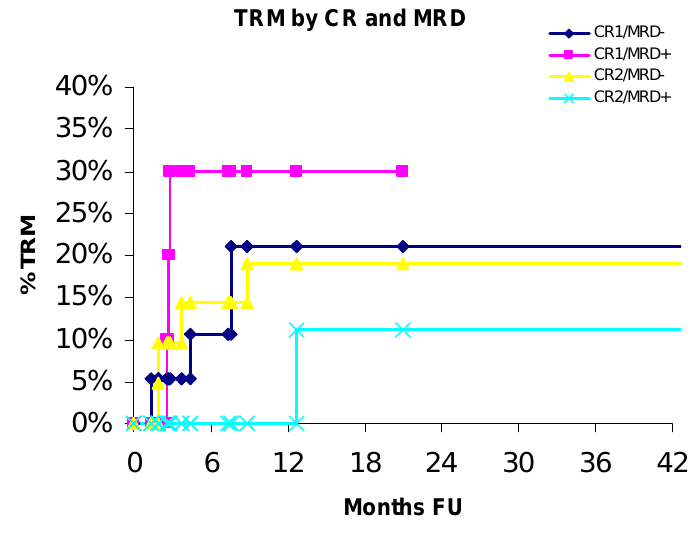
Figure 4. Transplantation related mortality by CR and